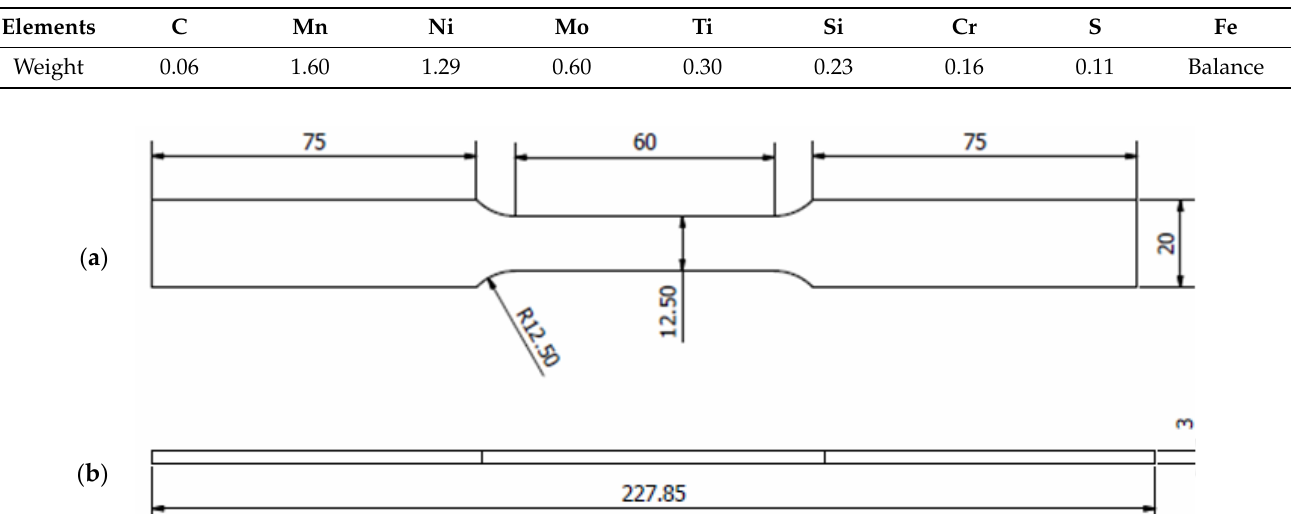
Table 1. The chemical properties of the API steel grade X65 [28].